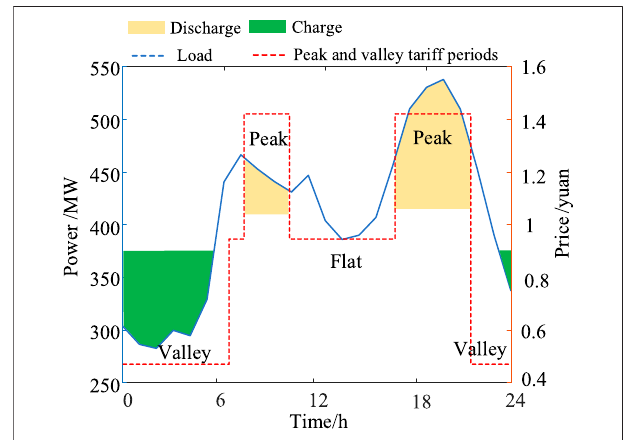
FIGURE 1 | Schematic diagram of peak-valley arbitrage of energy